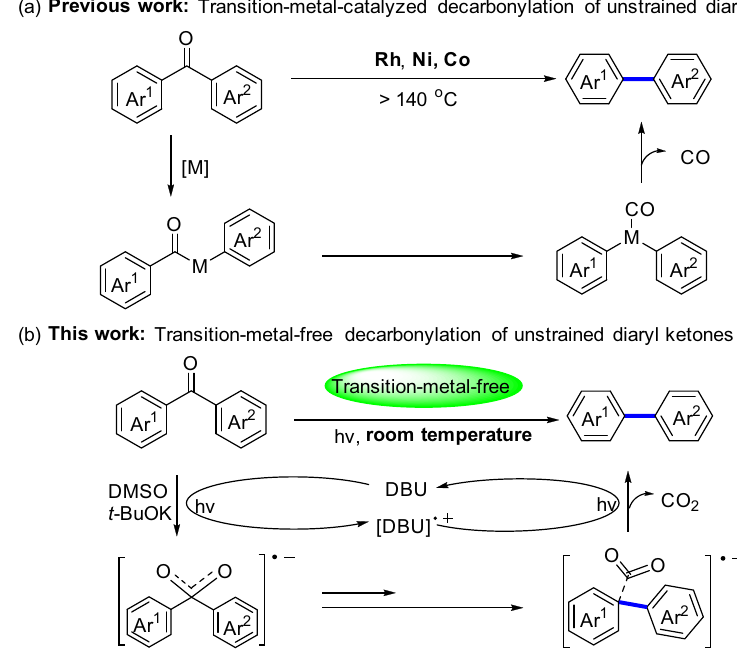
Fig. 1 Strategies for decarbonylation of unstrained aryl ketones. a Transition-metal-catalyzed decarbonylation of unstrained diaryl ketones. b Transition- metal-free decarbonylation of unstrained diaryl